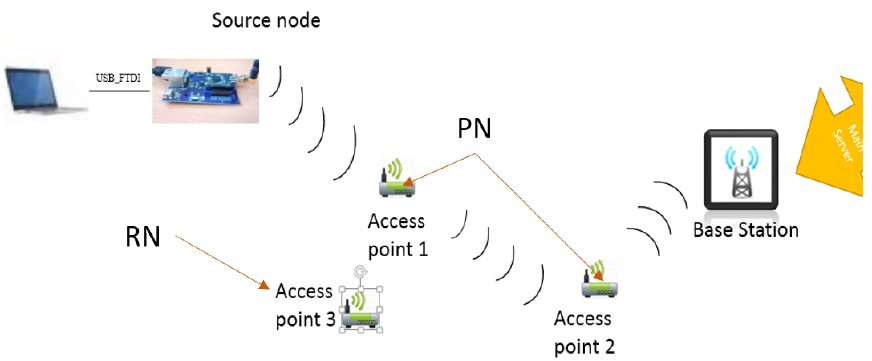
Figure 16. Experimental setup of the network.